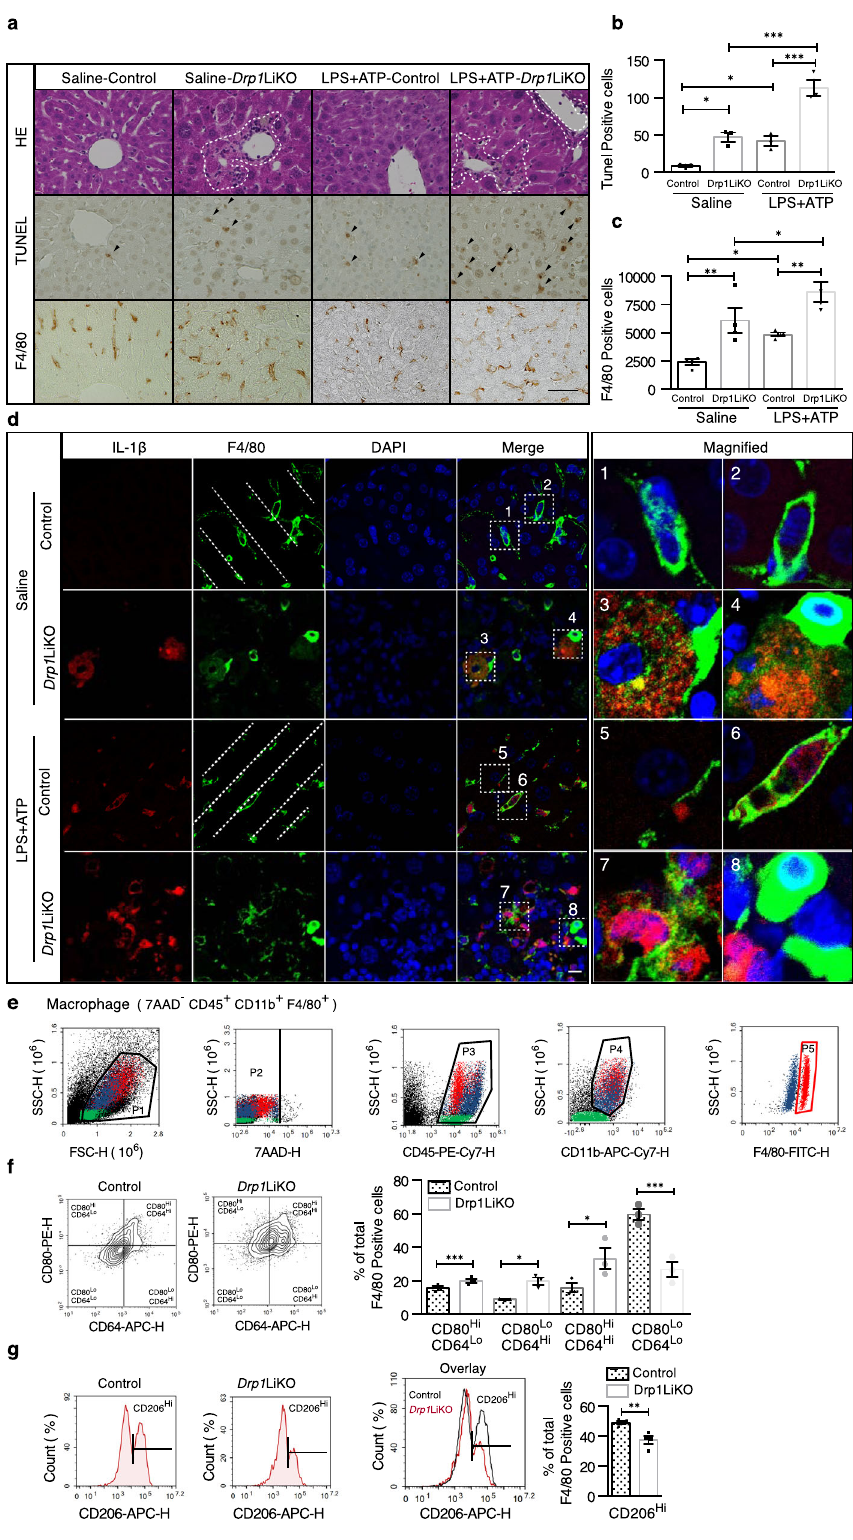
680 upregulated and 559 downregulated genes in Drp1 LiKO cells. We used the DAVID tool for functional clustering of upregulated and downregulated genes via similarly annotated GO biological process terms. The top fi ve enriched annotation clusters of upregulated genes are shown in Fig. 5b. All fi ve clusters for upregulated genes were related to the immune system: the immune system process, defense response to virus, innate